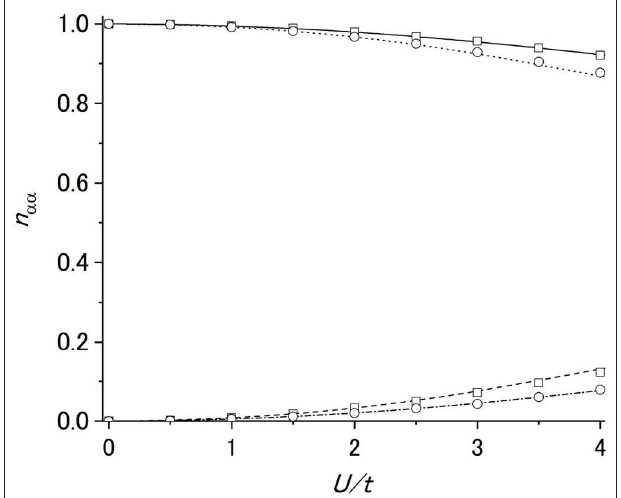
FIGURE 5 | Ground-state energy E tot calculated in TDDM1 (dots) as a function of U / t for N 6 with half-filling. The exact solutions are displayed with the solid = line. Adapted from Tohyama [ 33] under the Creative Commons CCBY license.